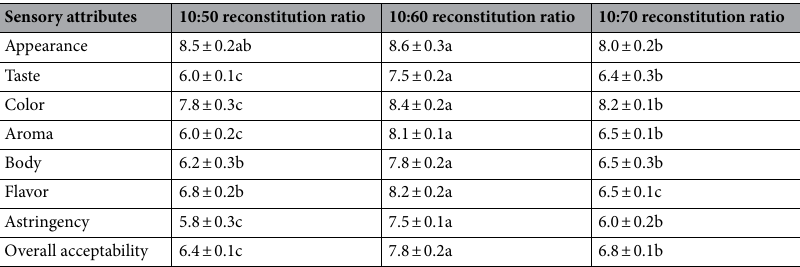
10:50 reconstitution ratio 10:60 reconstitution ratio 10:70 reconstitution